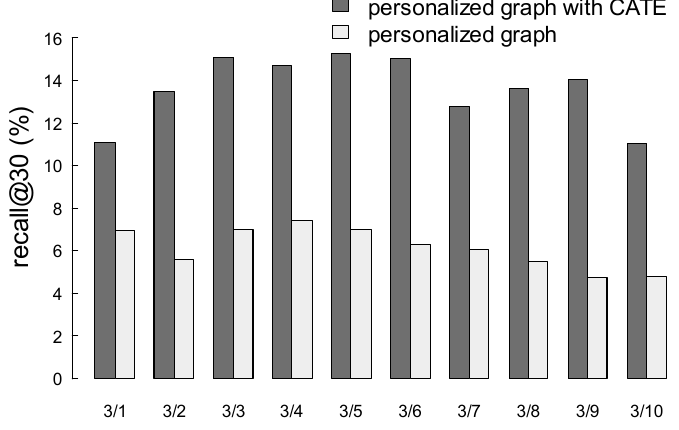
Figure 12. Temporal change in performance.